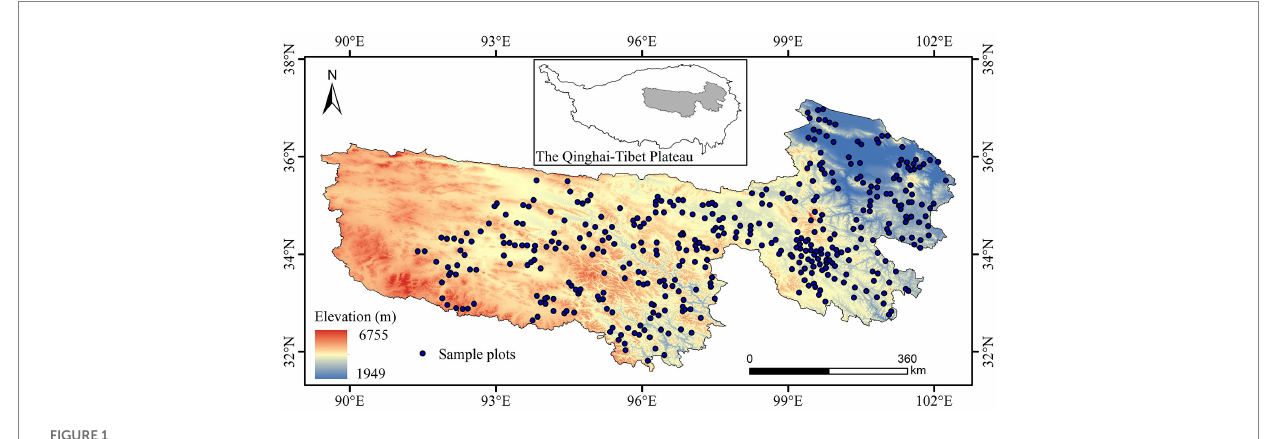
FIGURE 1 Location of the study area and spatial distribution of sample